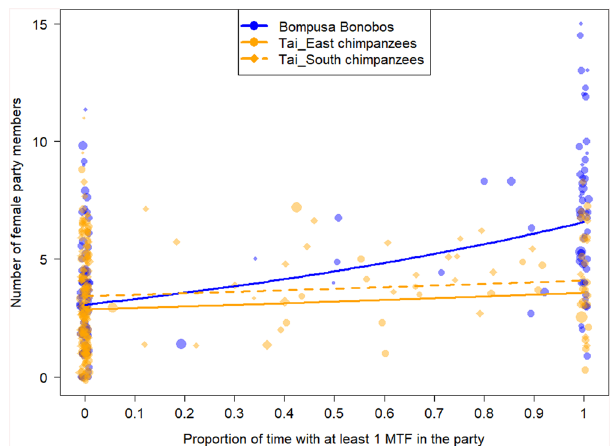
Fig. 3 Effect of the proportion of time with at least one maximally tumescent females (MTF) during a given day on the number of females in the party of the focal female. The Bompusa bonobo community is depicted in blue and the two Taï chimpanzee communities are depicted in orange (round dots for Taï East and diamond dots for Taï South). Each dot represents a half-day focal follow and the size of the dots represents the number of data points (i.e. number of 30 min parties) for a given value. The lines indicate the model line controlling for food availability, dominance rank, time of the day, and multiple sampling of the same individuals in solid blue, solid orange, and dashed orange for Bompusa, Taï East, and Taï South respectively (Model